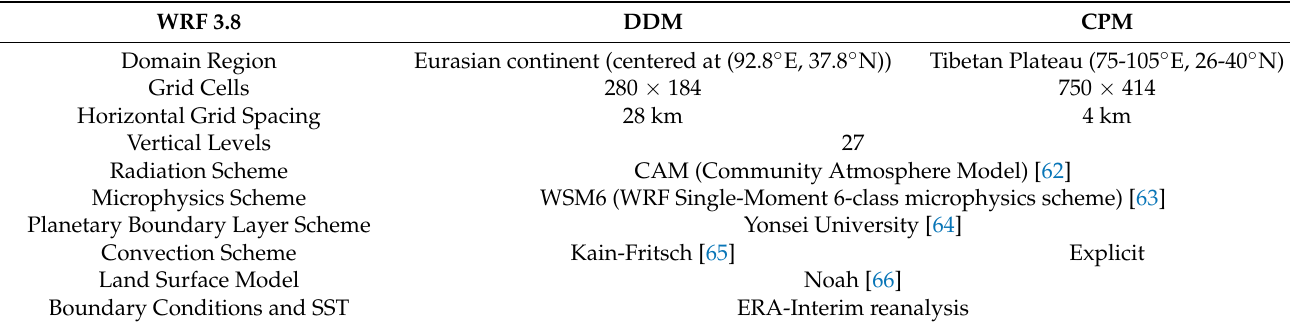
Table 1. The Weather Research and Forecasting (WRF) model configurations for dynamical downscaling modeling (DDM) and convection-permitting modeling